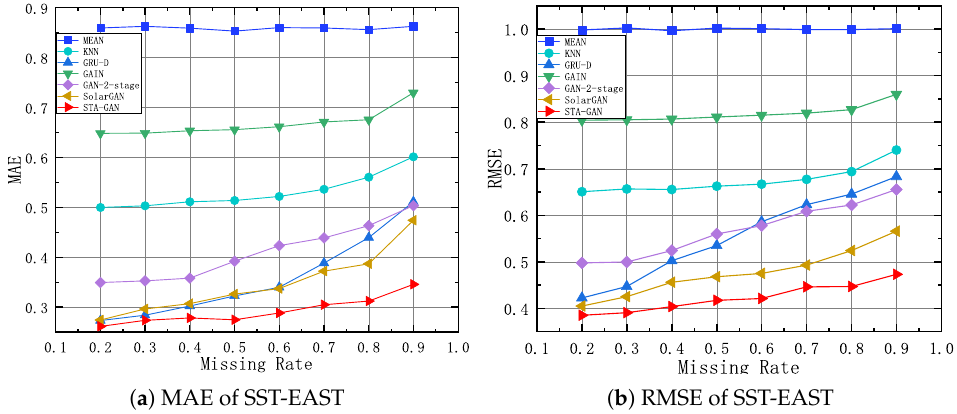
Figure 12. MAE and RMSE of SST-EAST dataset with different missing rates.